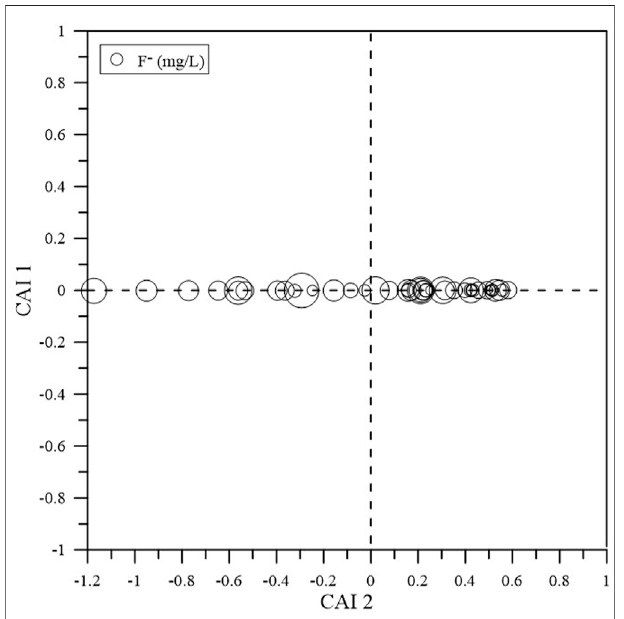
FIGURE7| Ca 2+ versusMg 2+ toevaluatetheroleofcalciteanddolomite dissolution in groundwater chemistry, and SI fl uorite vs. F -